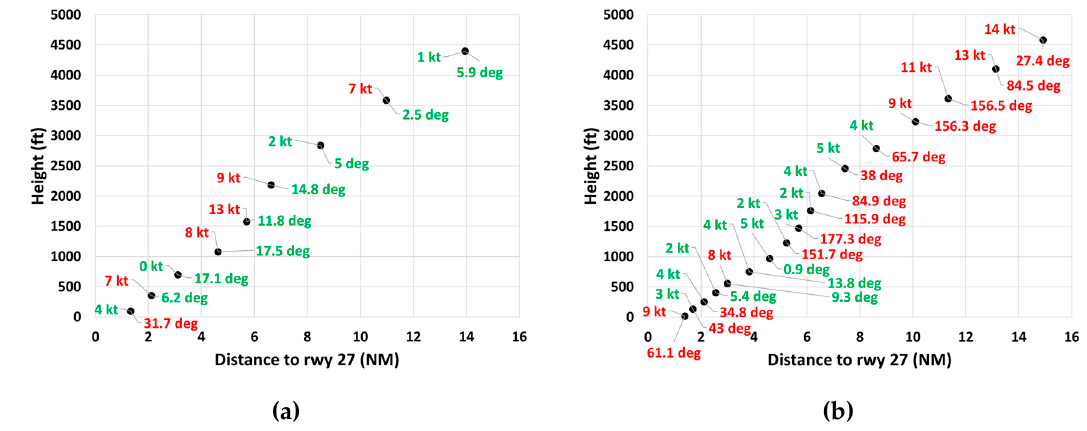
Figure 19. Absolute value di ff erences for wind speed and direction for: ( a ) Flight 1 and ( b ) Flight 2.